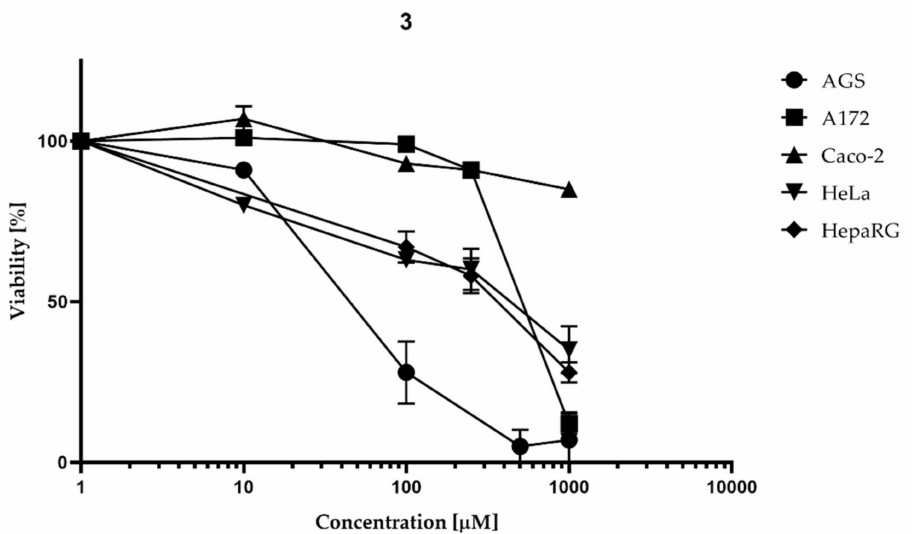
Figure 8. Viability changes after 72 h exposure to 3 . Concentrations applied to cells: 1000, 250, 100, and 10 µ M for Caco-2, A172, HepaRG, and HeLa; concentrations for AGS cell line: 1000, 500, 100, and 10 µ M. Concentrations were logarithmized, and viability was calculated as